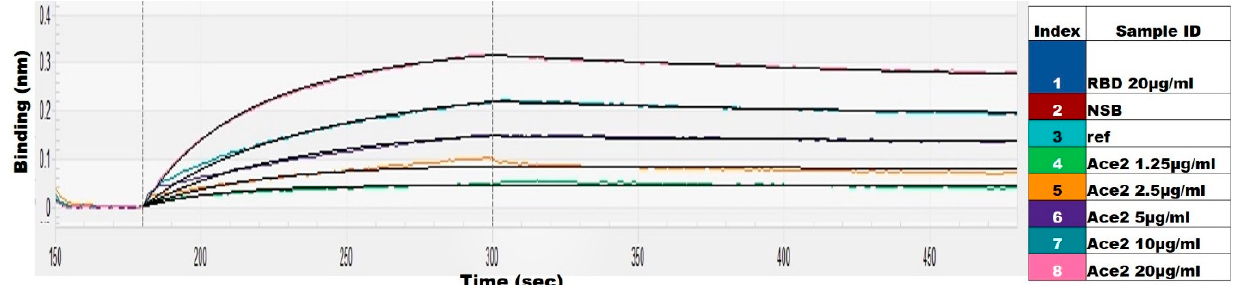
Figure 3. Determination of the binding of recombinant SARS-CoV-2 RBD through the OCTET − N1 Biomolecular Interaction Analyzer. ACE2 in the mobile phase at concentrations of 1.25, 2.5, 5, 10, and 20 µ g/m was